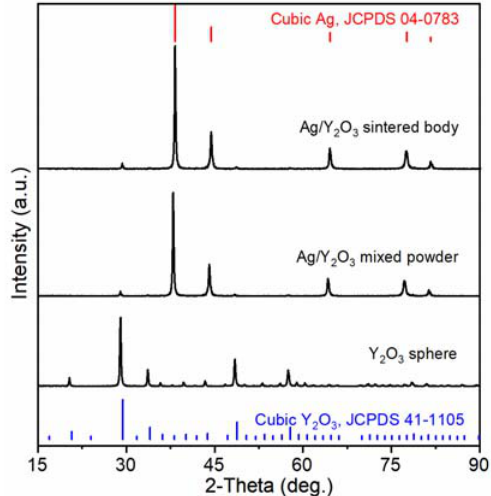
Figure 2. XRD patterns of Y 2 O 3 spheres, Ag/Y 2 O 3 mixed powder, and Ag/Y 2 O 3 sintered body.